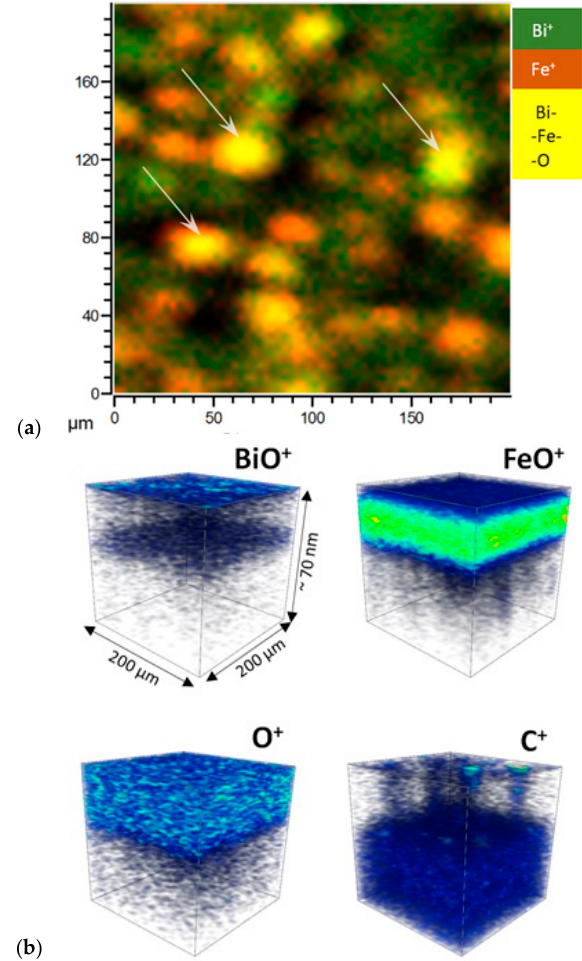
Figure 3. SIMS of the sample surface: composition of the components Fe, Bi, C and their combined image ( a ), an the combined image demonstrates the presence of BFO phase obtained in the process of the film deposition ( b ).